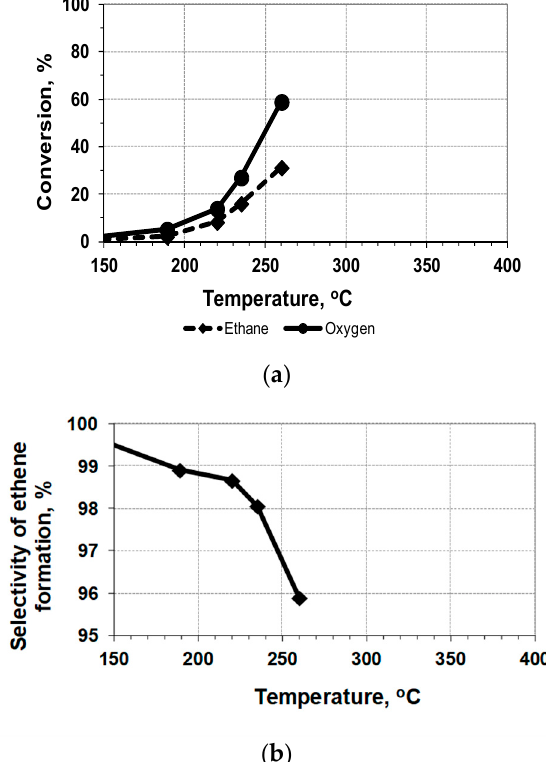
Figure 3. ODE with mw -heating of the undiluted sample Mo-V-Te-Nb-O x (0.37 g; 0.3 cc): ( a )—conversion of reagents; ( b )—selectivity of C 2 H 4 formation; gas mixture [75%C 2 H 6 +25%O 2 ], flow rate = 660 cm 3 /h, GHSV = 2200 h − 1 .